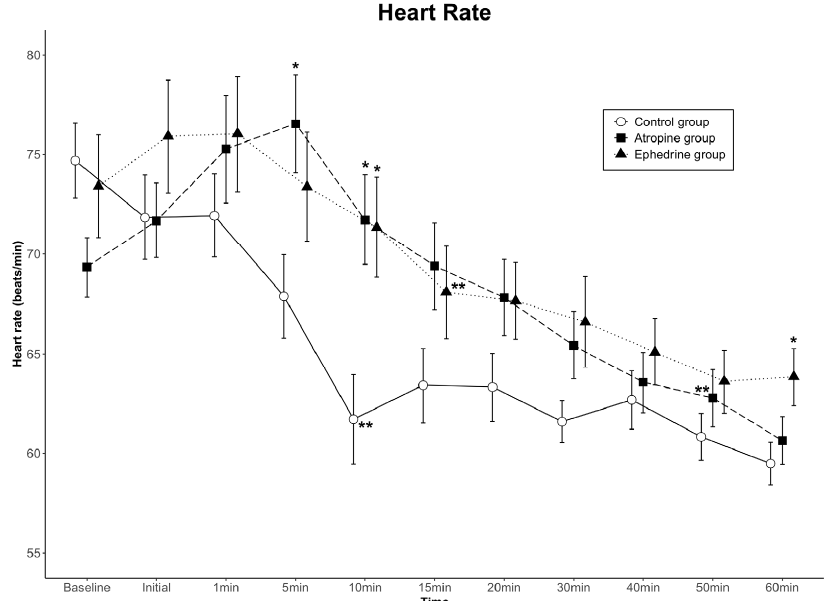
Figure 2. Heart rate (HR) values for the three groups. Data are presented as mean ± standard error. A significant time-by-group interaction was observed among the groups ( p < 0.001). The HRs at 5 and 10 min in the atropine group were higher than those in the control group, and the HRs at 10 and 60 min in the ephedrine group were higher than those in the control group (* p < 0.05 compared to the control group in the same period by one-way ANOVA). The HR was maintained at lower than the baseline HR of each group from 10 min in the control group, 15 min in the ephedrine group, and 50 min in the atropine group (** p < 0.05 compared to baseline within the group by Bonferroni method as a post hoc multiple comparison after repeated-measures ANOVA). Baseline, baseline value before spinal anesthesia: Initial, immediately before the administration of dexmedetomidine; 1–60 min, 1–60 min after the administration of dexmedetomidine. The data for mean arterial blood pressure are shown in Figure 3. Although blood pressure for each of the three groups changed over time ( p < 0.001), no significant differ- ences were found among the groups (group effect; p = 0.666 in SBP, p = 0.738 in MBP, p = 0.810 in DBP). No significant interactions were observed with time-by-group ( p = 0.383 in SBP, p = 0.772 in MBP, p = 0.386 in DBP). Overall, blood pressure was clinically stable in all groups.